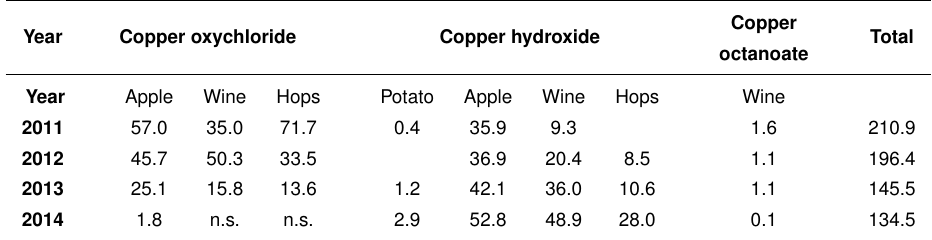
Table 5. Estimated crop-specific amounts [t] of copper-containing active substances used in conventional farming from 2011 to